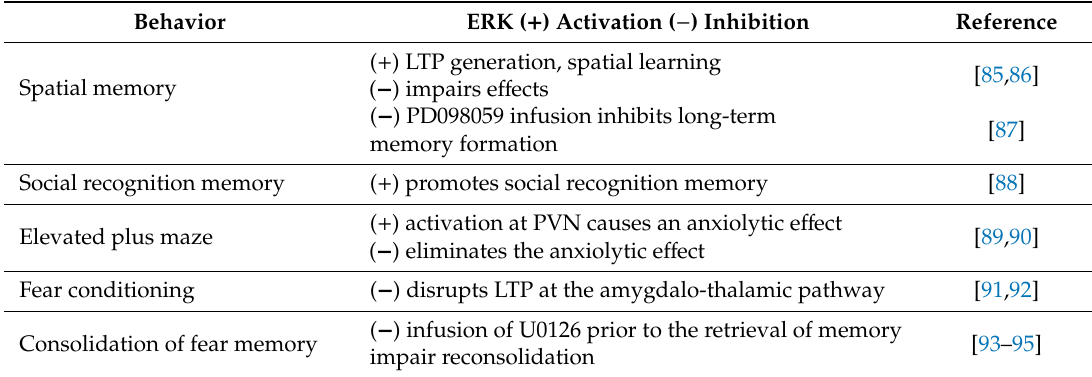
Table 2. ERK1 / 2 activation in